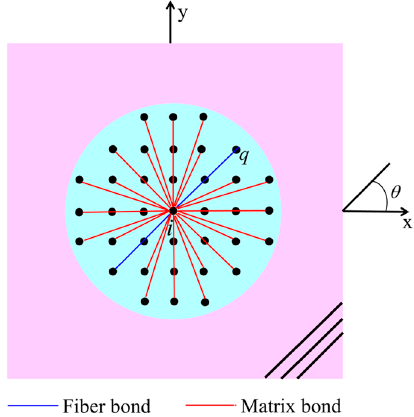
Figure 3. Two kinds of PD bonds in a lamina.